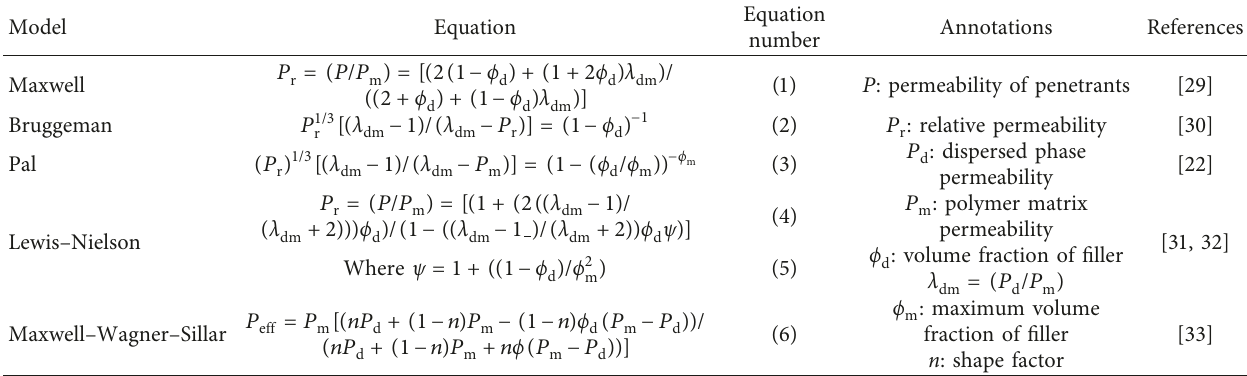
Table 1: Theoretical models for mixed matrix